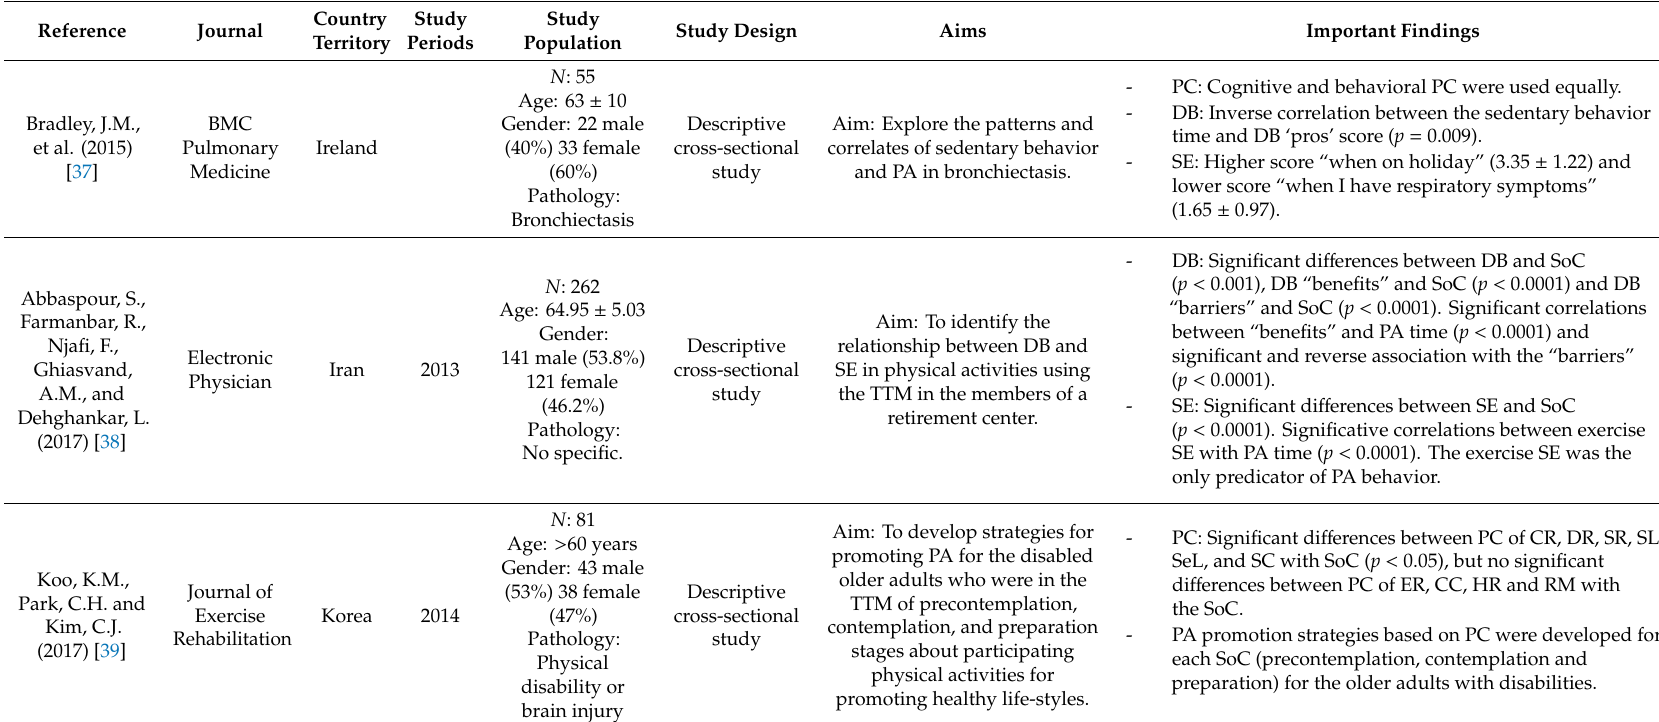
Table 3. TTM in older